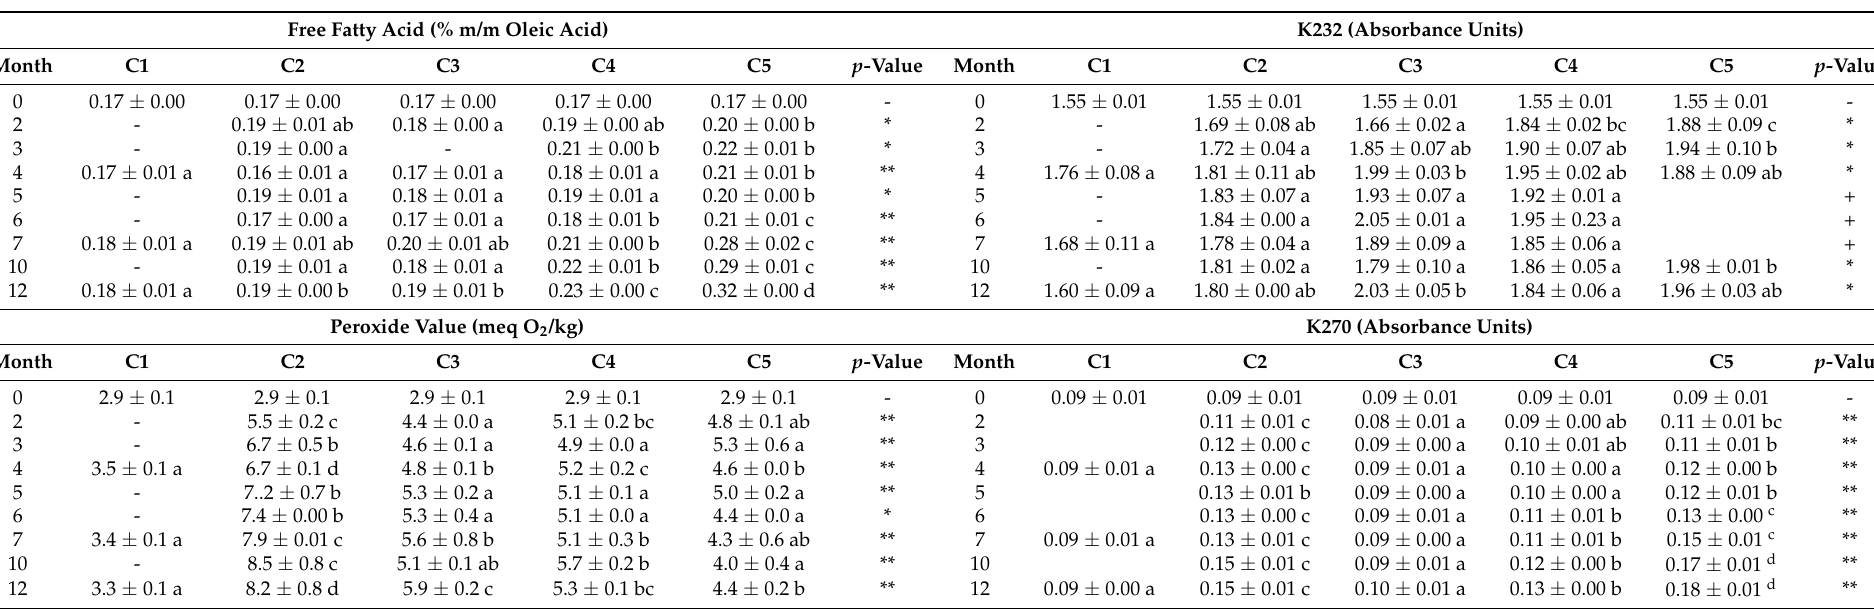
Table 1. Variation of free fatty acid, peroxide value, K232 and K270 in Arbequina variety EVOO, subjected to different temperature and light condition during 12 months of storage. Free Fatty Acid (% m/m Oleic